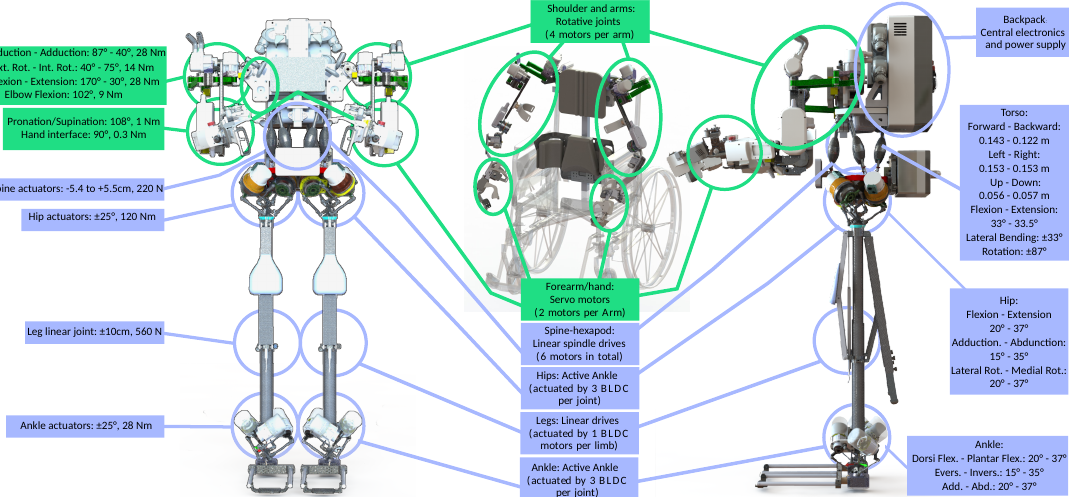
Figure 2. R ECUPERA exoskeleton configurations (left and right: full-body, middle: wheelchair) with its ROM and force/torque capabilities. Modules highlighted in green are used in both systems, mechanisms highlighted in blue only in the fullbody system. Full-body system (weight = 42kg, height = 1.70–1.90m) is driven by 28 brush-less direct current (BLDC) and 4 servo motors. Wheelchair system (weight = 8.6kg, 29.2kg including commercial wheelchair) is driven by 8 BLDC and 4 servo